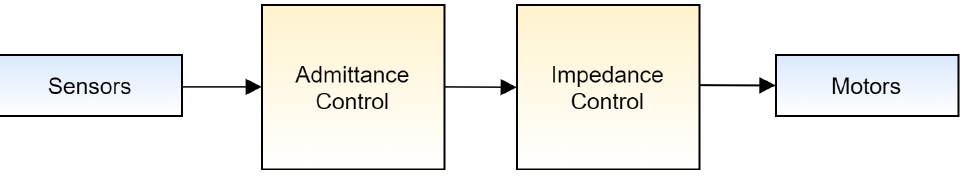
Figure 2. Hybrid control system.